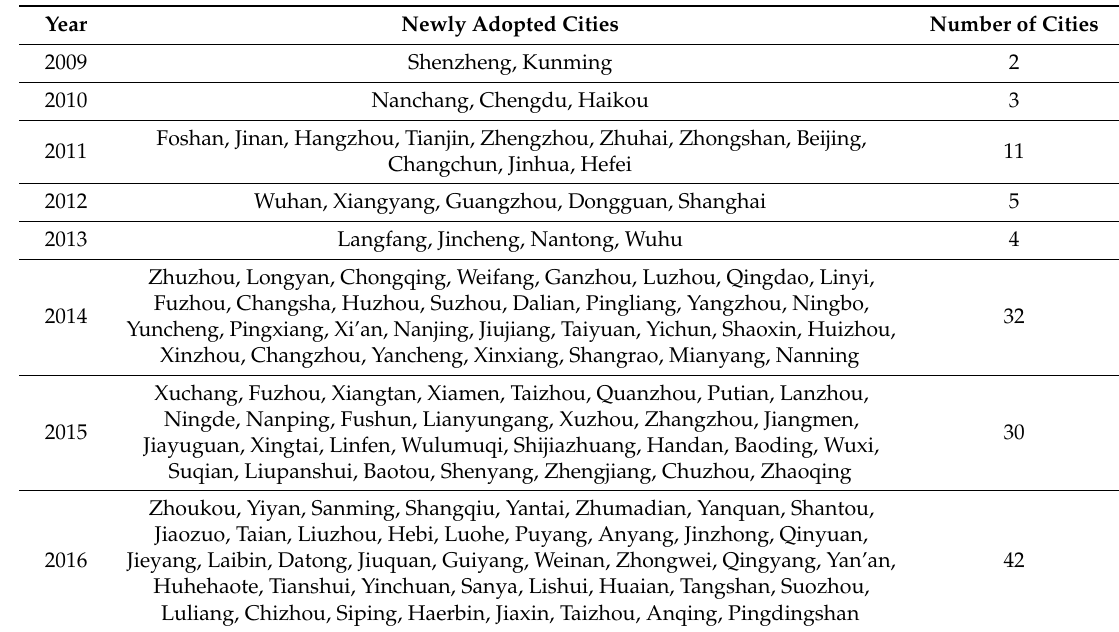
Table 1. Timeline of new policy adoption.